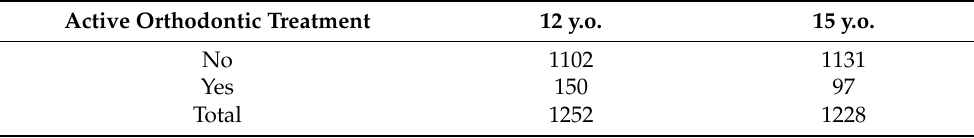
Table 2. Subjects in active orthodontic treatment by age.